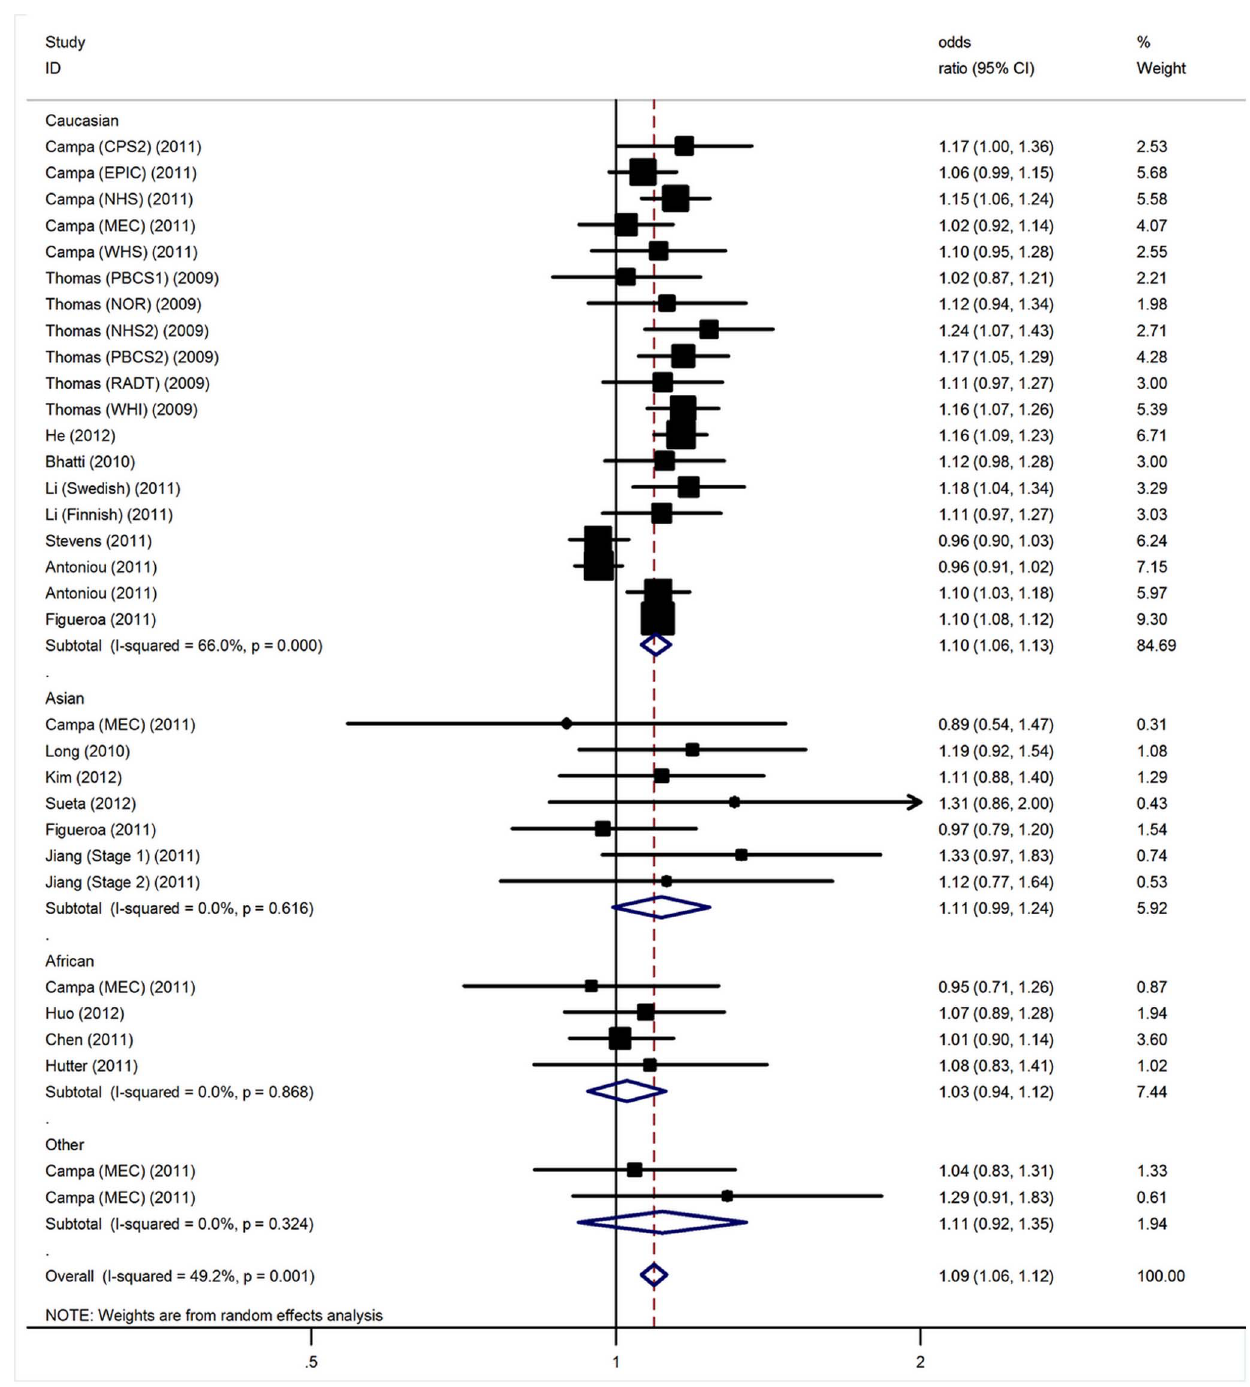
Figure 1. Forest plot for association of 1p11-rs11249433 polymorphism and BC risk.